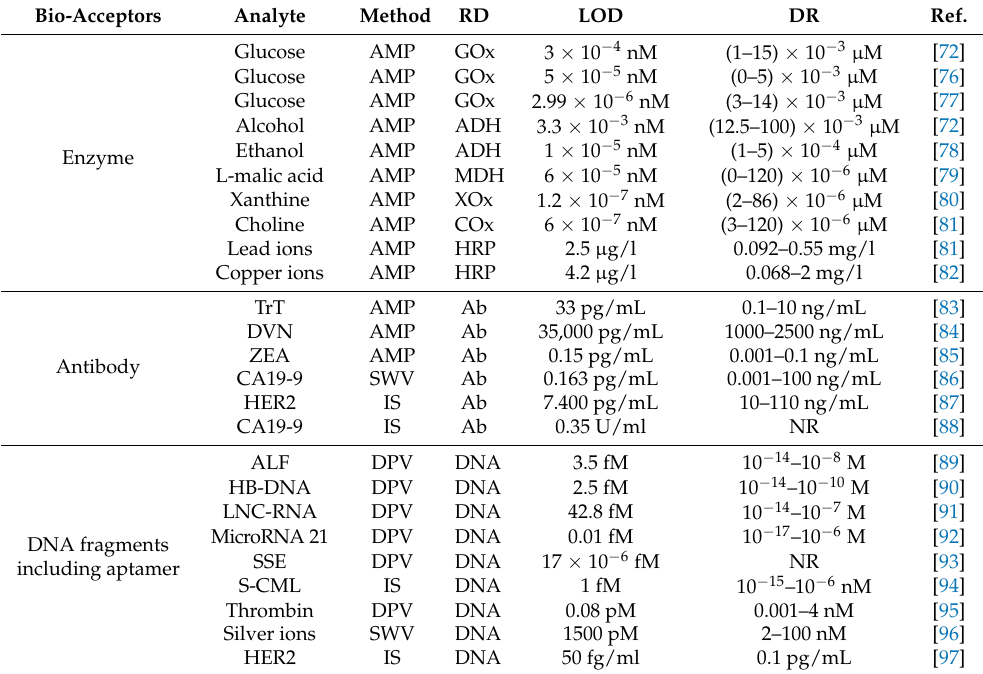
Table 1. Summary of CNT-based electrochemical biosensors with various bio-acceptors (enzyme, antibody, and DNA fragment including aptamer).